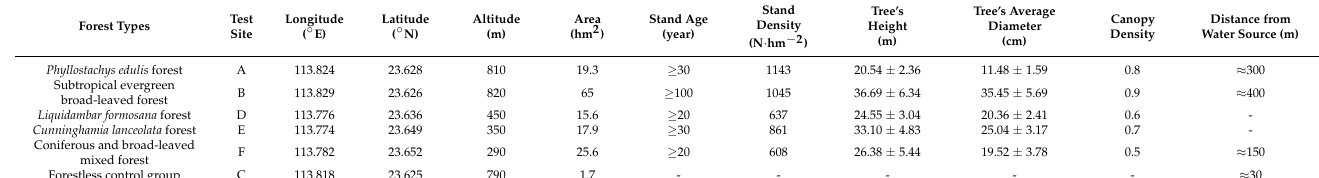
Table 1. Overview of the sample plots.